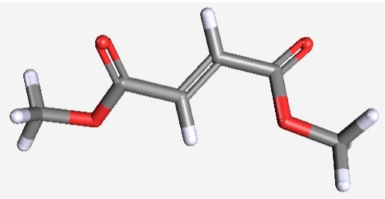
Figure 1. Chemical structure of Dimethylfumarate performed with Jmol (Jmol: an open-source Java viewer for chemical structures in 3D. http: // www.jmol.org /